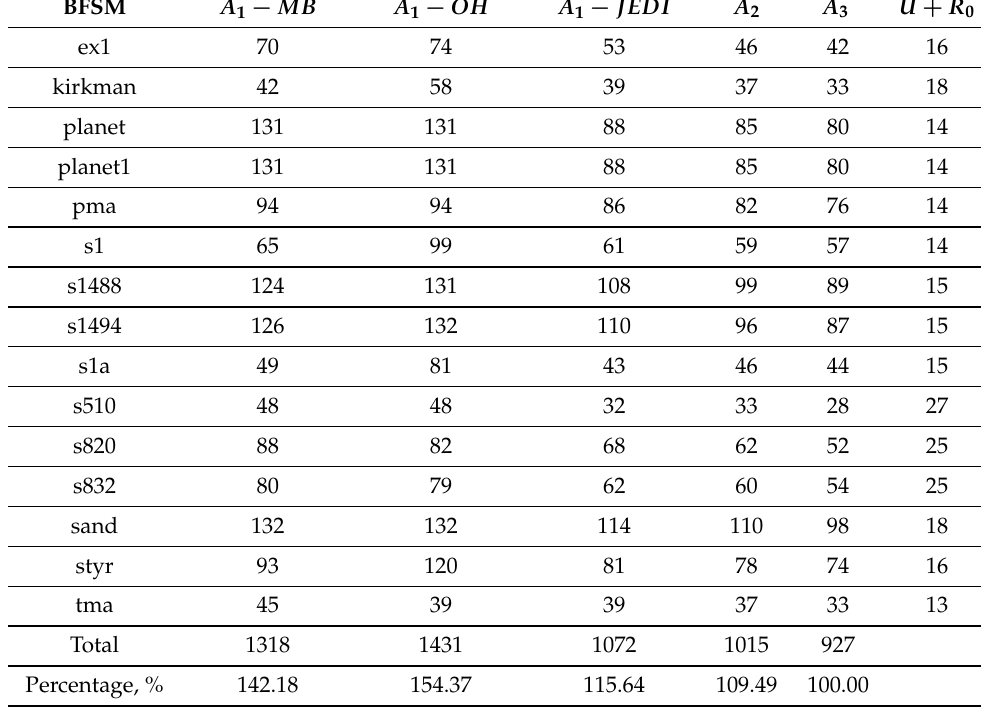
Table 10. Results of experiments (LUT